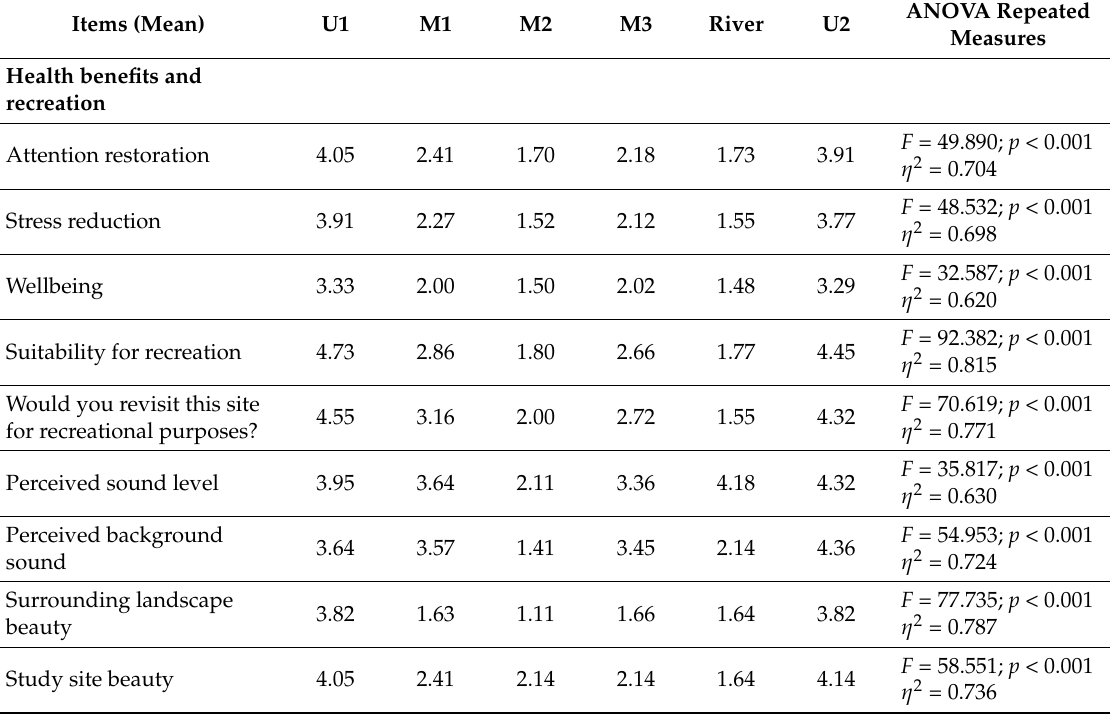
Table 5. Means of perceived health effects, recreation, noise and landscape beauty per study site ( N = 22).